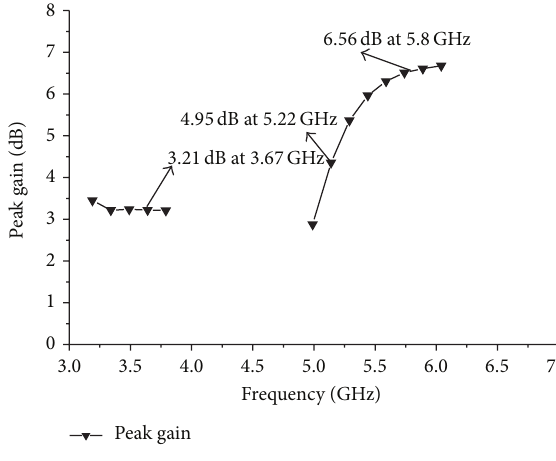
Figure 15: Peak gain of the proposed antenna.